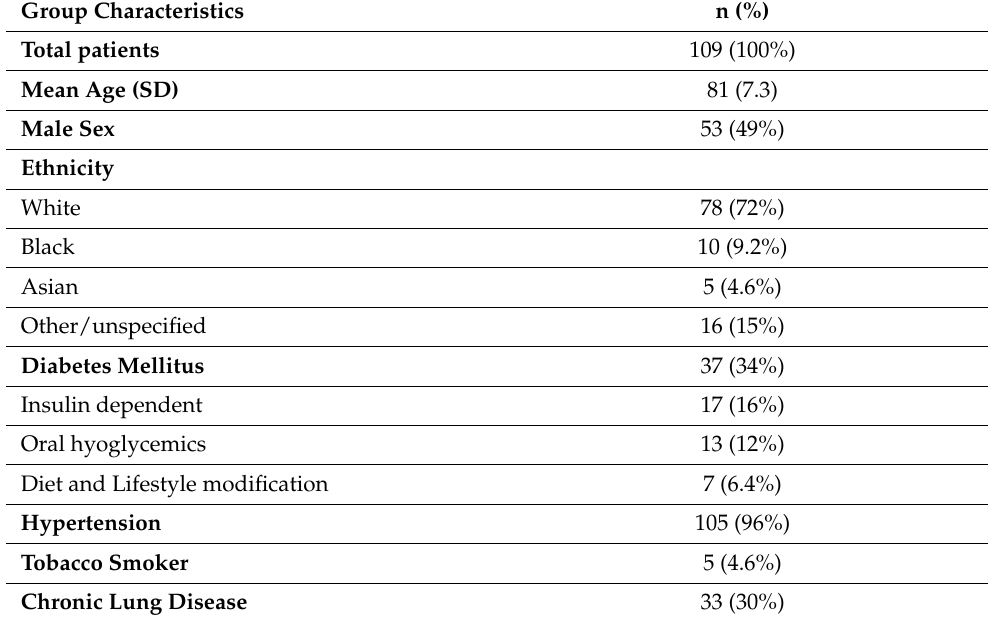
Table 1. Baseline Patient